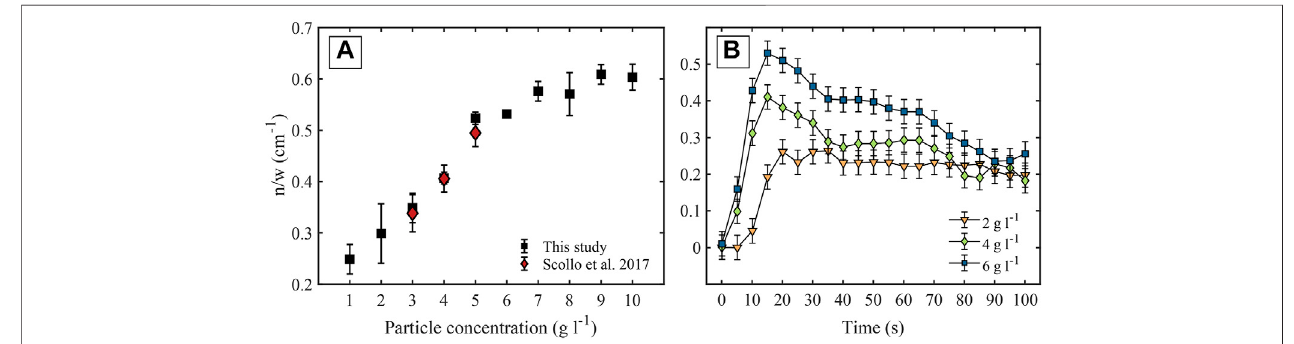
( Supplementary Figure S7 ; Supplementary Videos S2, S3 ), with ( Figure 6C ). Measurements are well fi tted by the relation t i (cid:2) ( α / g ′ ) , where α (cid:2) 0.2 m s − 1 is an empirically- fi tted constant, dimensionally homogeneous to velocity. By analogy with the expected timescale of PBL growth, we presume that the constant α , which governs the increase of the density inside the PBL, is inversely proportional to the individual settling speed of particles.